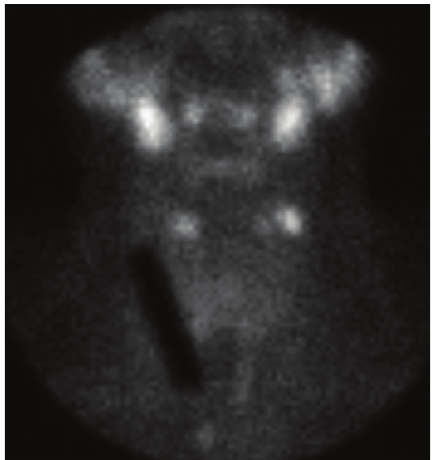
Figure2:I-131thyroidscanat24hours.Markedlydiminishedradio- tracer accumulation is seen throughout the gland. The photopenic parallelogram over the right neck area is due to a 1 cm × 5 cm lead marker placed over the skin for size estimation